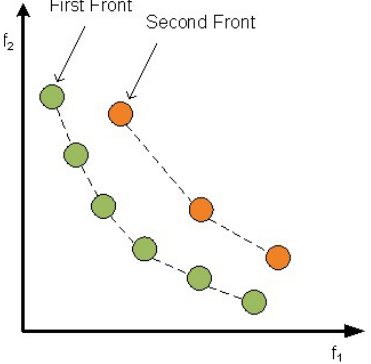
Fig. 4. Diagram of non-dominated sorting